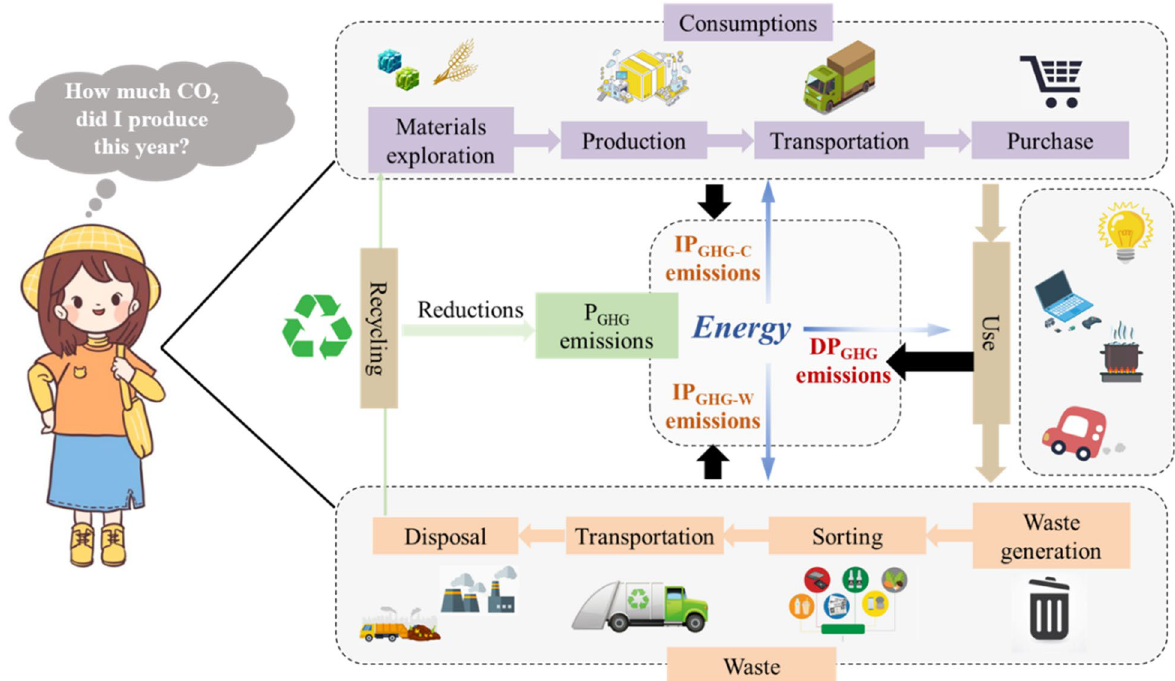
Fig. 1 System boundary and the detailed scope of the P GHG